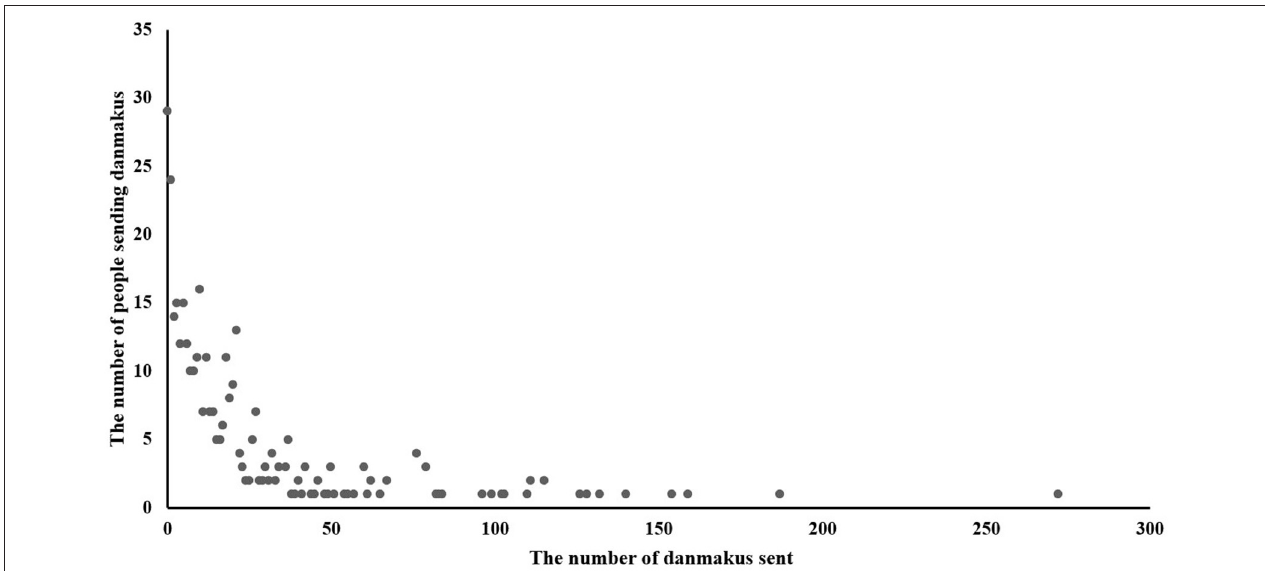
FIGURE 6 | The scatter figure of the number of people sending danmakus and the number of danmakus